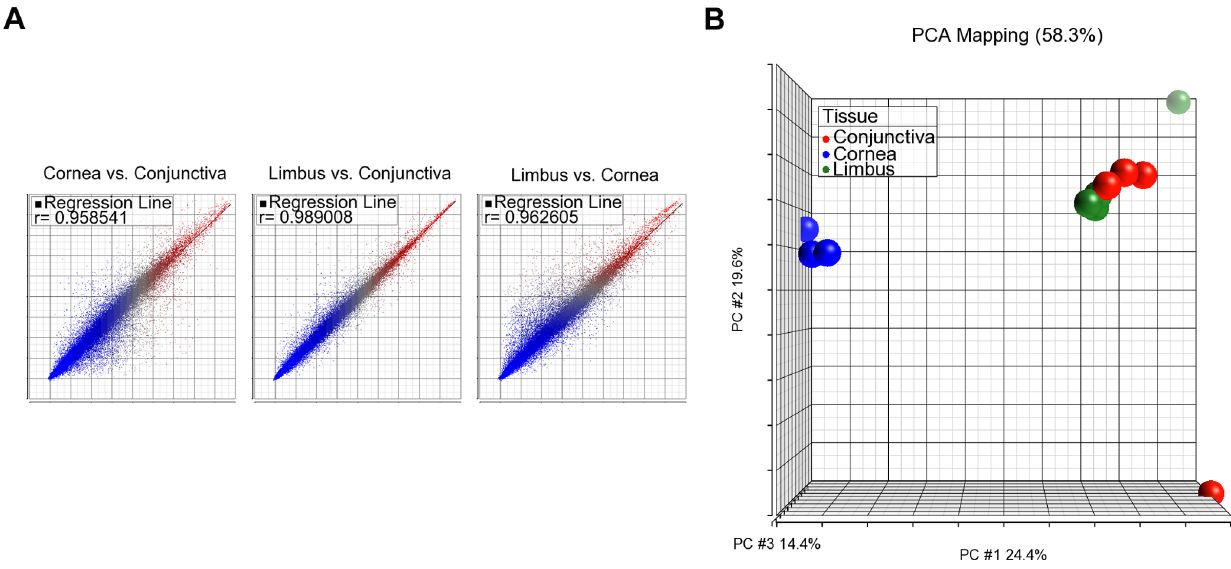
Figure 1. Tissue correlation of global gene expression between ocular samples. A) Pairwise scatter plots of the correlation of transcript expression between cornea, conjunctiva and limbus. High correlation was observed between the limbus and conjunctiva, r=0.989. Lower correlation was observed between the limbus and cornea, r=0.962, and cornea and conjunctiva, r=0.958. B) PCA analysis between the 11 samples from the cornea, conjunctiva and limbus. Each sample was clustered into common groups based on global gene expression. High correlation was observed between the limbus (green) and conjunctiva (red) and low correlation was observed between the cornea (blue) versus the limbus and conjunctiva.